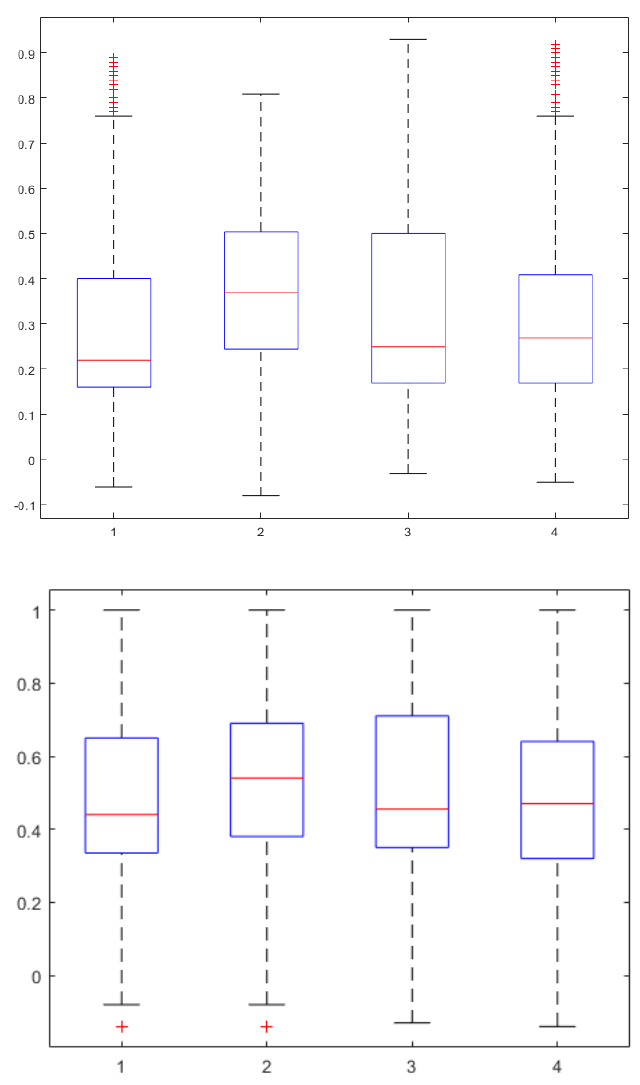
Figure 9. ( Top ) Boxplot of the NDVI values of the four areas of interest over the Csanádpalota ‐ Juhász T. tanya site. The X ‐ axis corresponds to the selected area (area 1 is located in the outline of the circular enclosure of the site, area 2, at the center of the site, area 3 over a linear feature, and area 4 at a cultivated field in close proximity to the site), while Y ‐ axis corresponds to the NDVI value (range ‐ 1 to +1). ( Bottom ) Boxplot of the same areas based on the ARVI index.